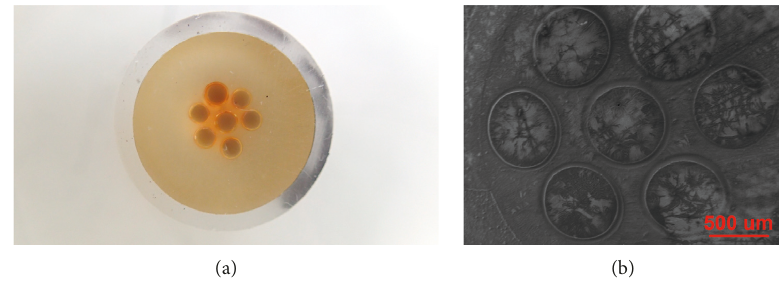
Figure 3: A cross-sectional (a) image and (b) SEM trace of the 1-1-1-3 hybrid device.